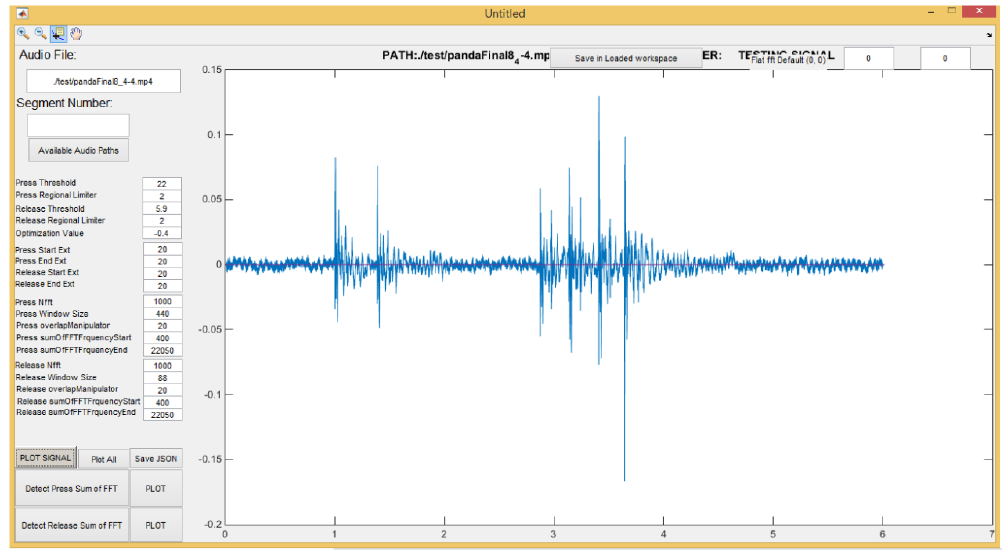
Figure 5. Custom MATLAB feature extraction